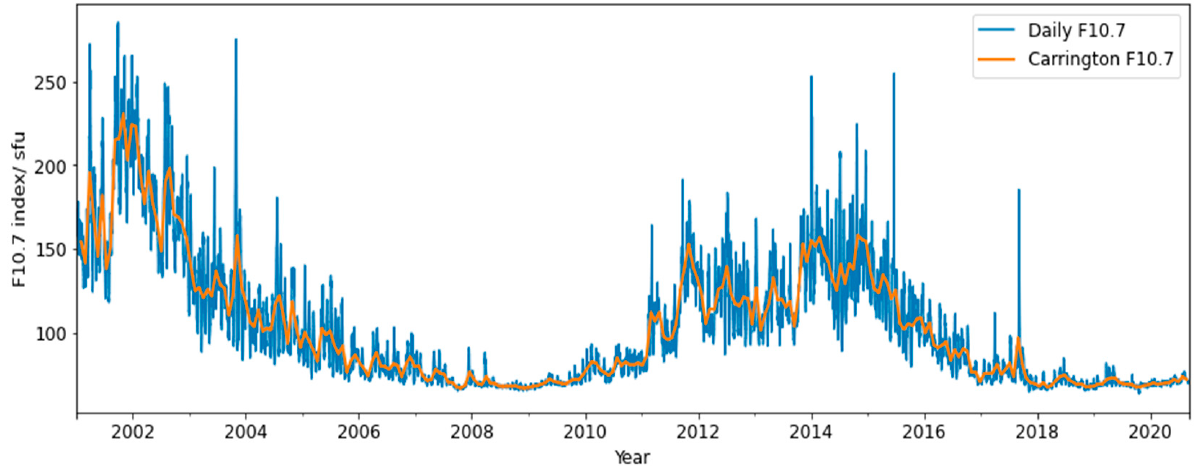
Figure 1. The daily and 27-day averaged Carrington rotation solar activity of the dataset used for training and testing the model where the dataset has approximately two solar cycles.